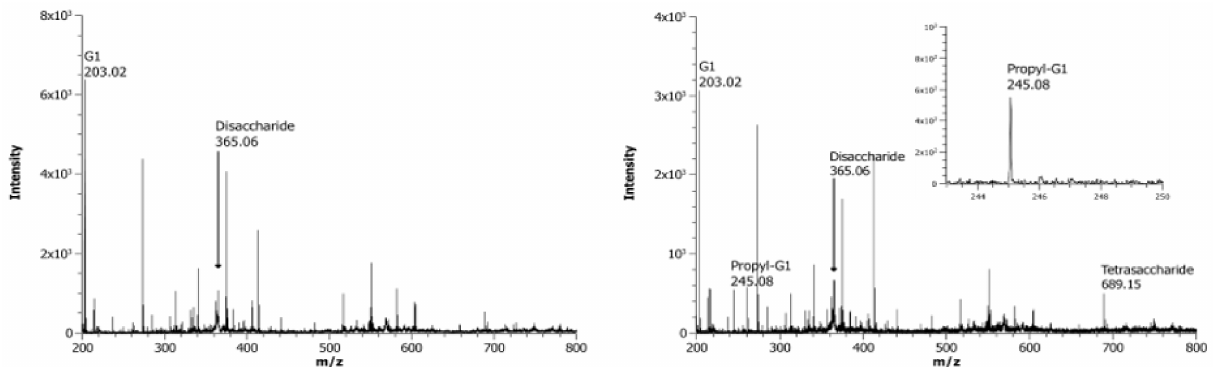
Figure 3. MALDI-TOF MS spectra of incubations with LBG. 8 nkat/mL Aga27A was incubated with 0.4 w/v % LBG alone ( left ) or with the addition of 5 v/v % propanol ( right ) at 37 ◦ C for 24 h. A peak corresponding to galactose (theoretical m / z for [m+Na + ]: 203.05), marked G1 in the spectra, was observed in both spectra. When incubated with LBG alone, transglycosylation products were observed in the form of a disaccharide (theoretical m / z for [m+Na + ]: 365.10). With propanol added, Aga27A generated transglycosylation products in the form propyl-G1 (theoretical m / z for [m+Na + ]: